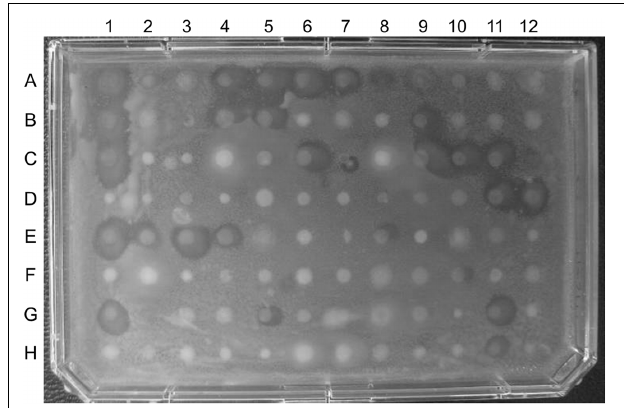
FIGURE 2 | Plate containing 96 of the 323 bacterial isolates cultured from marine Atlantic stingray ( D. sabina) mucus overlaid with vancomycin-resistant enterococcus (VRE). Zones of inhibition are visible in 30 of the 96 isolates assayed on this plate.